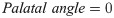
The effect on the curve when changing Alveolar weight, with Alveolar angle set to its extremes (compare to Fig 4 with Alveolar angle set to 0.5, and with Alveolar weight fixed to 0.5, respectively, while changing Alveolar angle).Palatal concavity and Palatal fronting are set to 0.5. The panels are: left (a): Palatalangle=0, and right (b): Palatalangle=1.